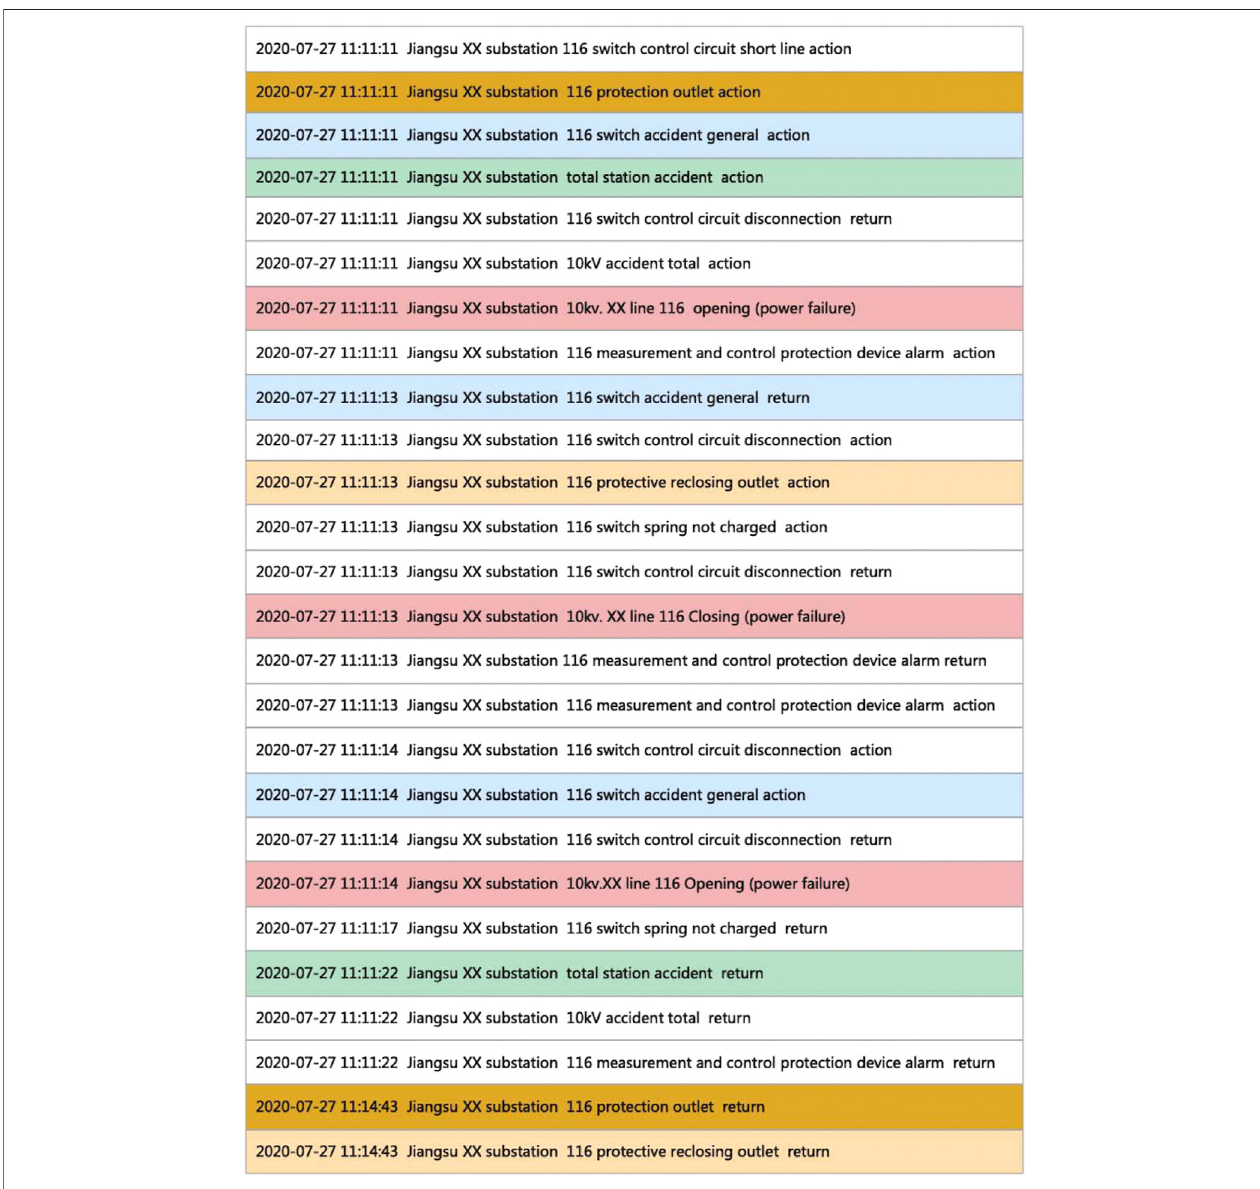
FIGURE 7 | Part of the experimental